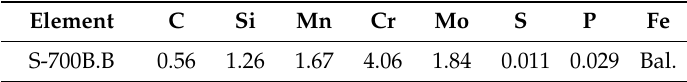
Table 3. Chemical compositions of the covered electrode (wt.%).